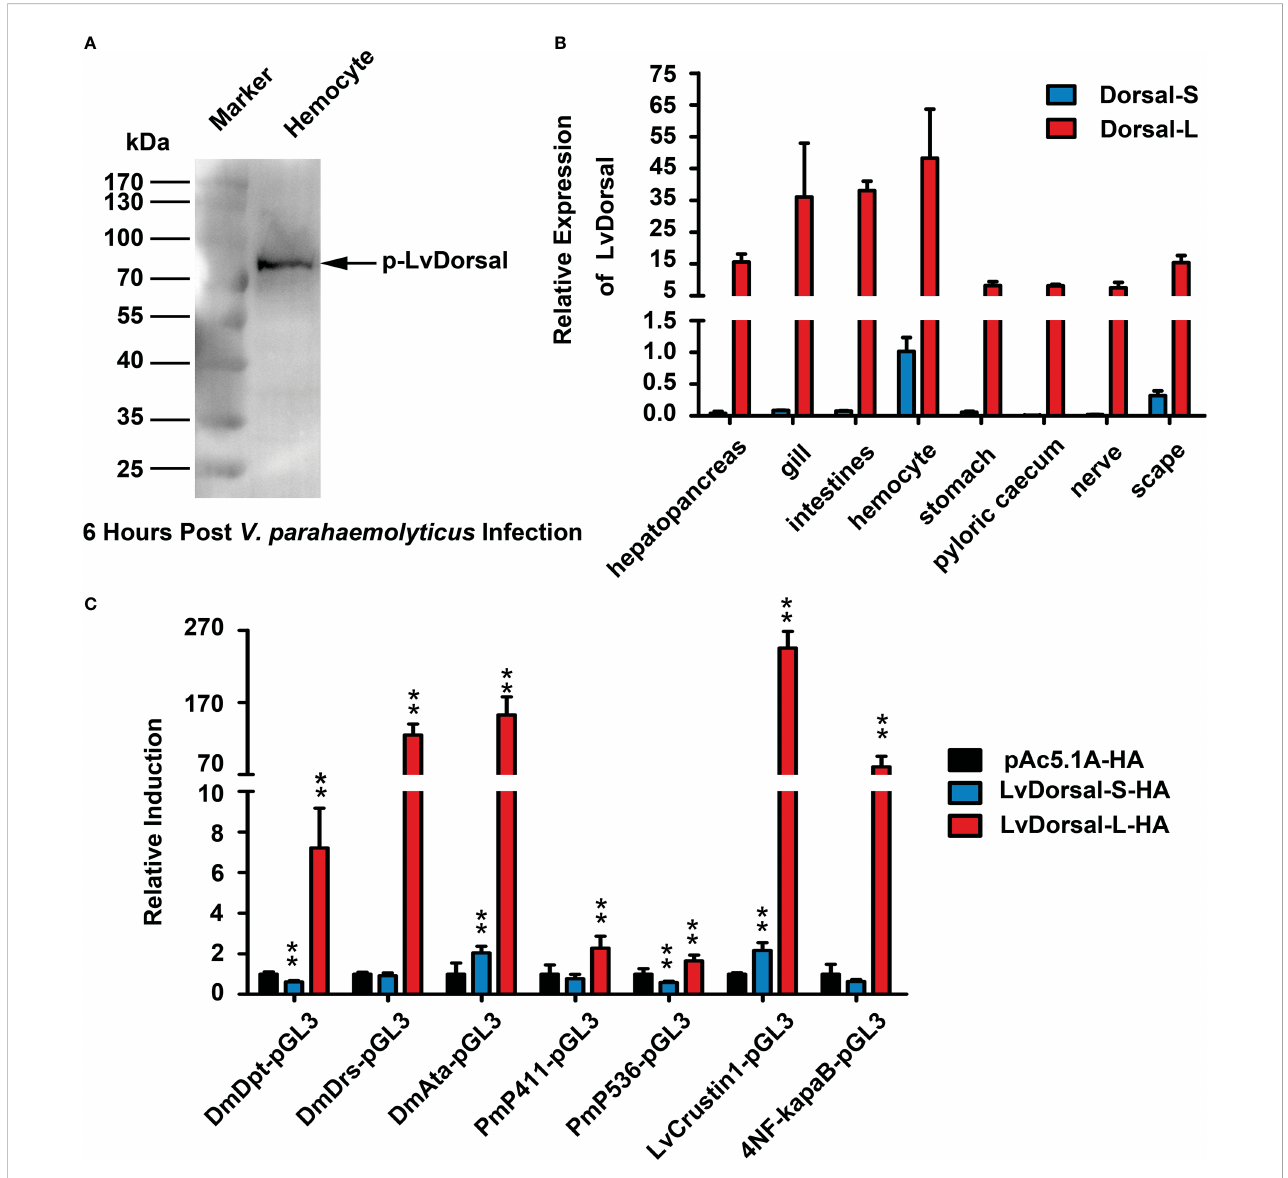
FIGURE 4 Characterization of LvDorsal-L. (A) LvDorsal phosphorylation in hemocytes of V. parahaemolyticus -infected shrimp. (B) LvDorsal-S and LvDorsal-L tissue distributions in healthy L. vannamei . (C) The effects of LvDorsals on the promoter activities of AMP genes and the NF- k B binding site. All the data (B, C) were provided as the means ± SD of at least three assays, and analyzed statistically by student ’ s T test (**: p <